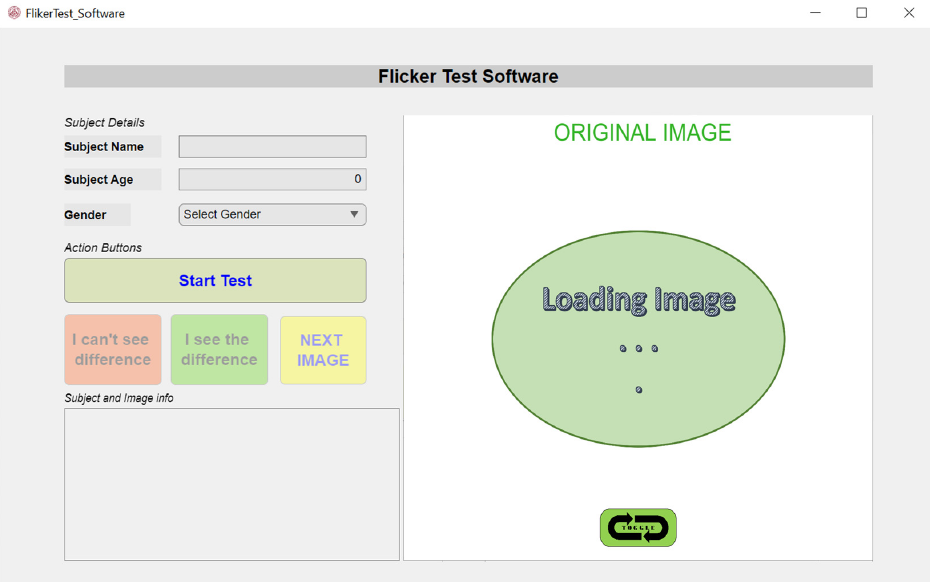
Figure 2. The user interface of the developed “Flicker Test Software”.